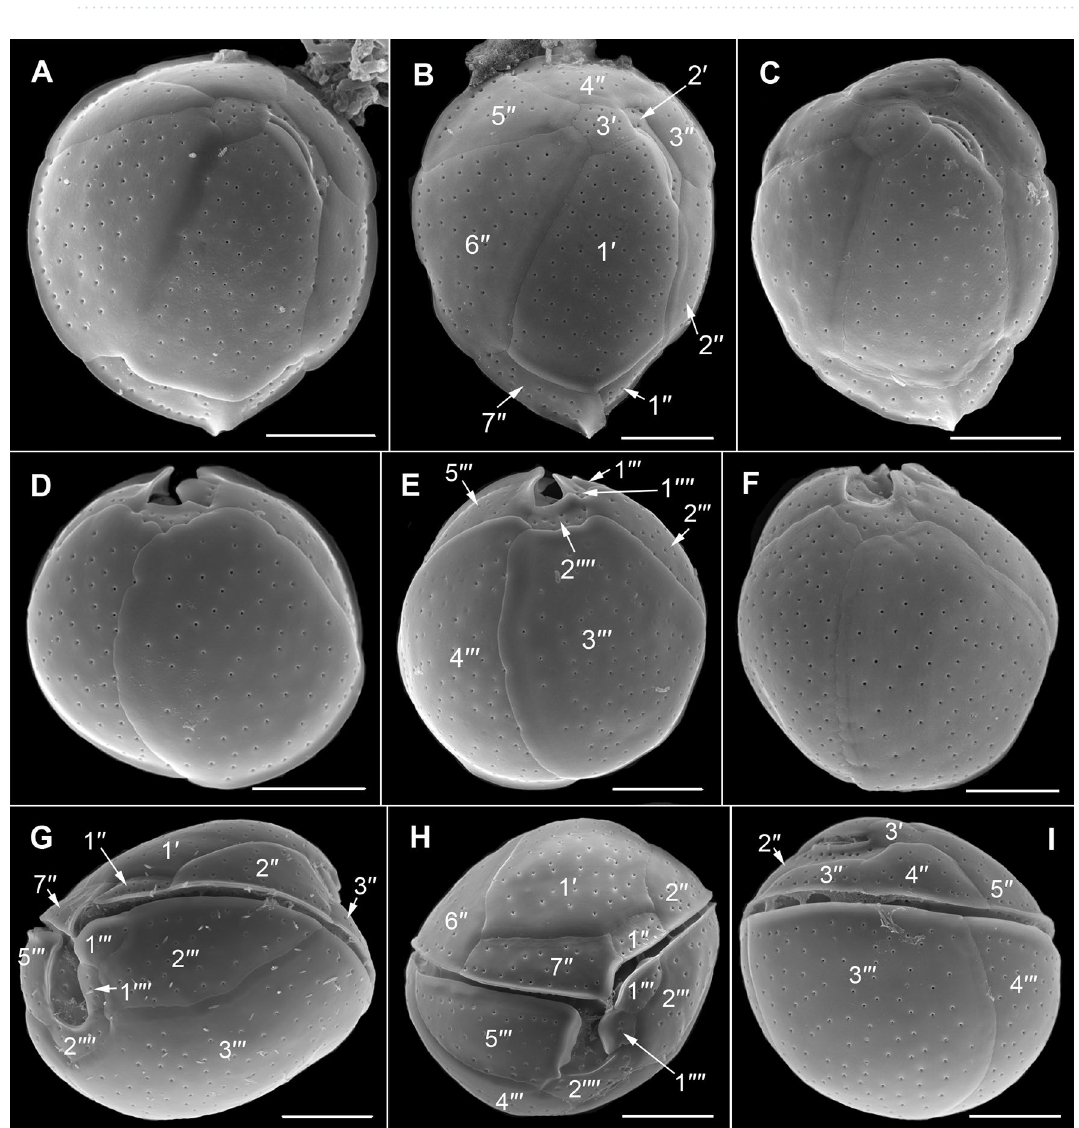
Figure 12. Scanning electron micrographs of Coolia tropicalis strain C11C2 showing the thecal tabulation. ( A–C ) Apical view of the epitheca. ( D–F ) Antapical view of the hypotheca. ( A-F ) Note the different shapes partly depending on the growth band development. ( G ) Left lateral to ventral view. ( H ) Ventral view. ( I ) Dorsal view. Scale bars = 10